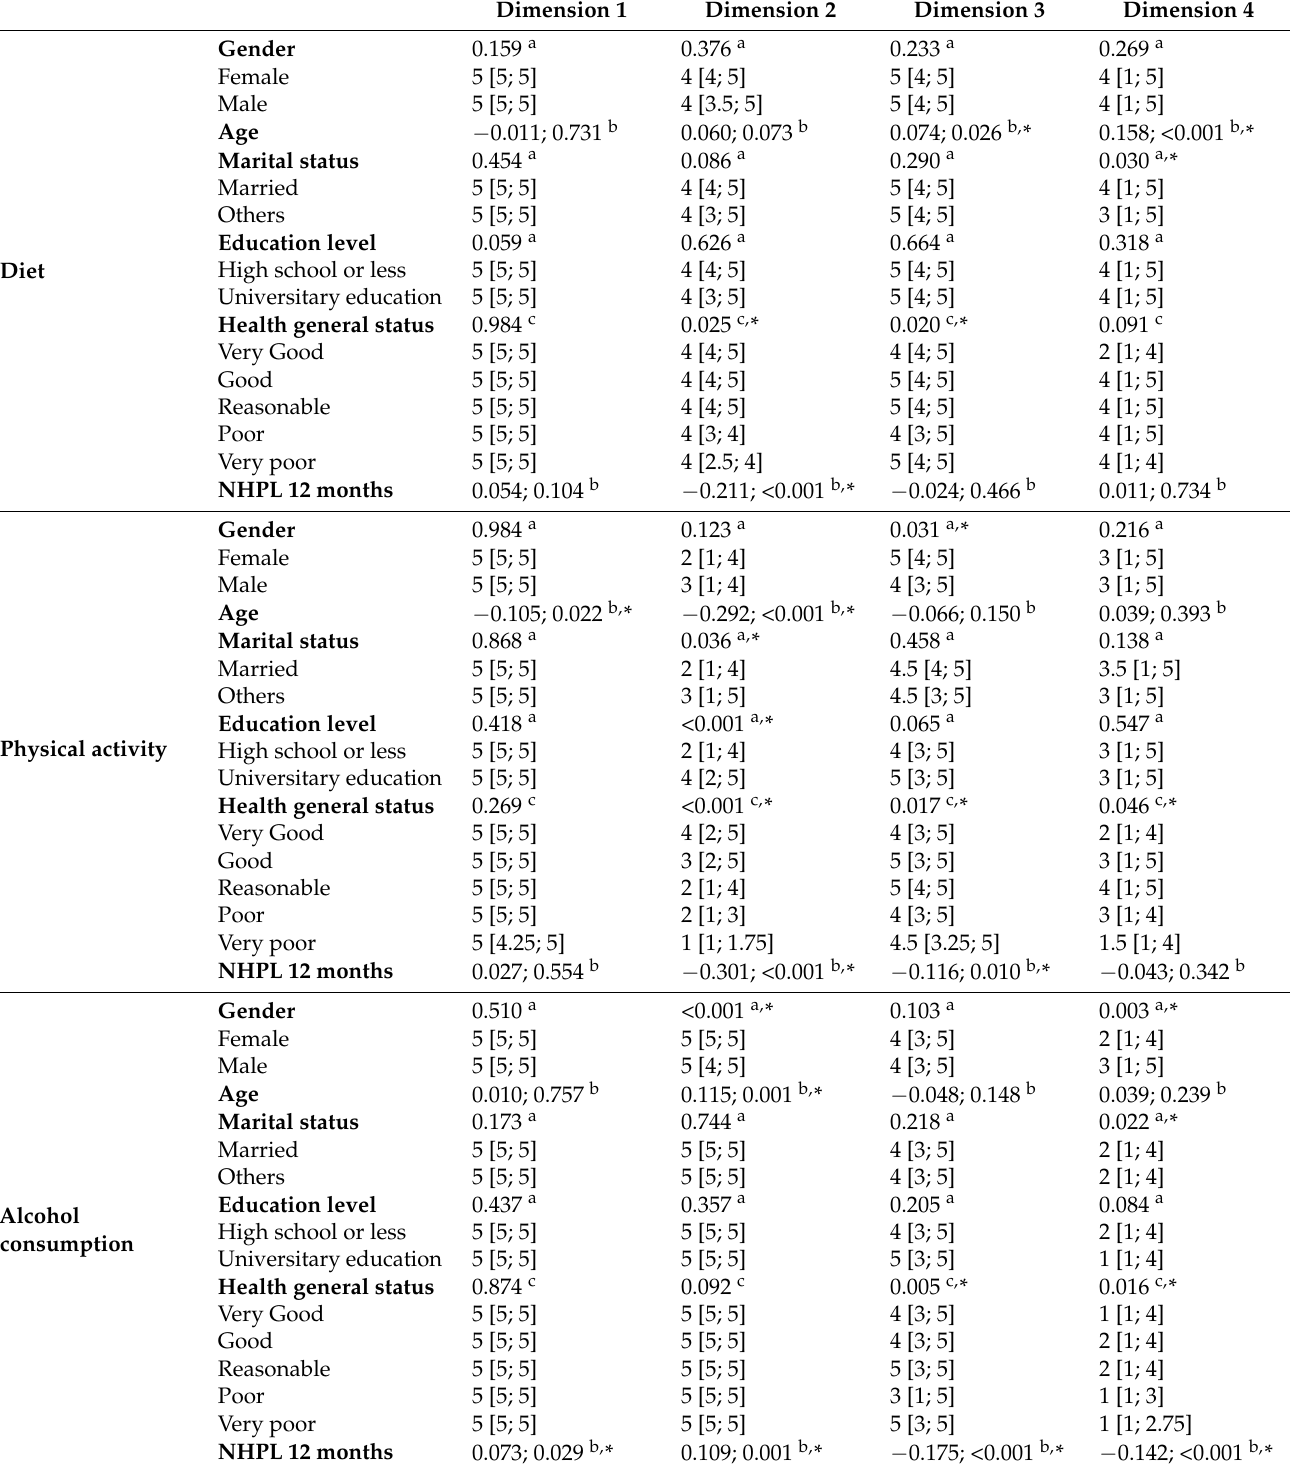
Table 5. Association between lifestyle behaviors and bio-demographic